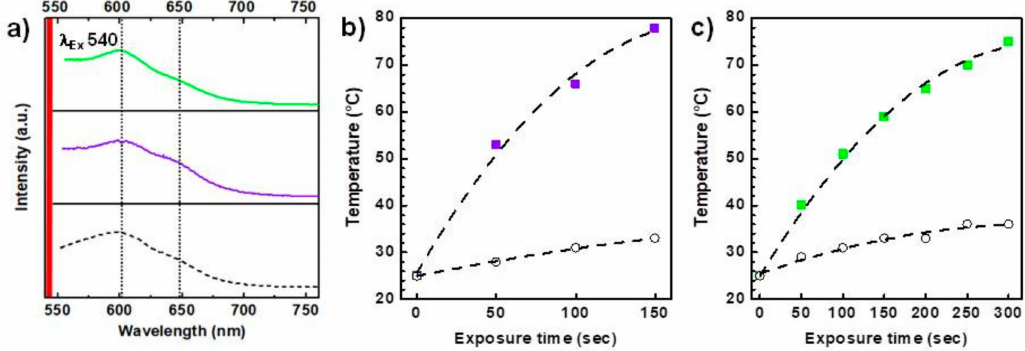
Figure 4. Emission spectra of CDs (black dash), PLGA-CDs20% NPs (purple solid) and PLGA-CDs1% NPs (green solid) in water ( a ). Photothermal kinetics of PLGA-CDs20% NPs (2.5 W cm − 2 ) ( b ) and PLGA-CDs1%NPs (7 W cm − 2 ) ( c ) (0.1 mg mL − 1 ): ultrapure water was used as negative control (dark open